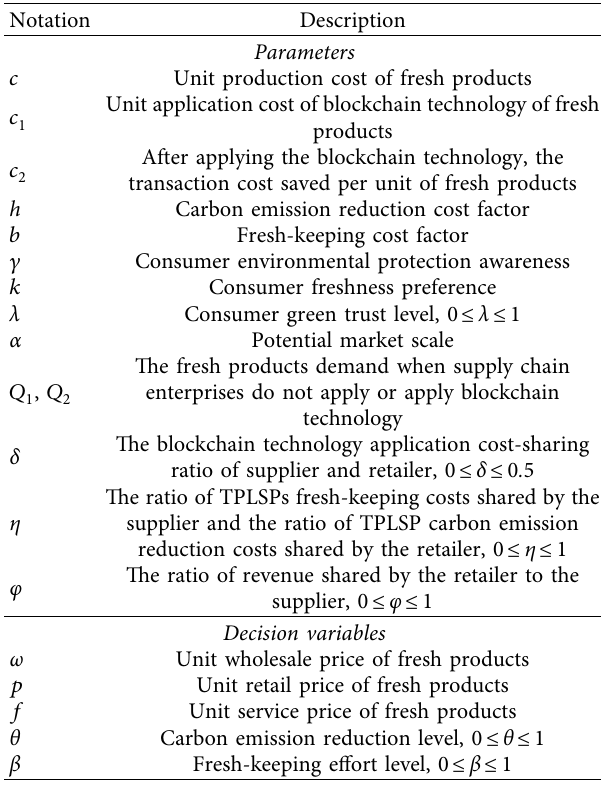
Table 2: List of